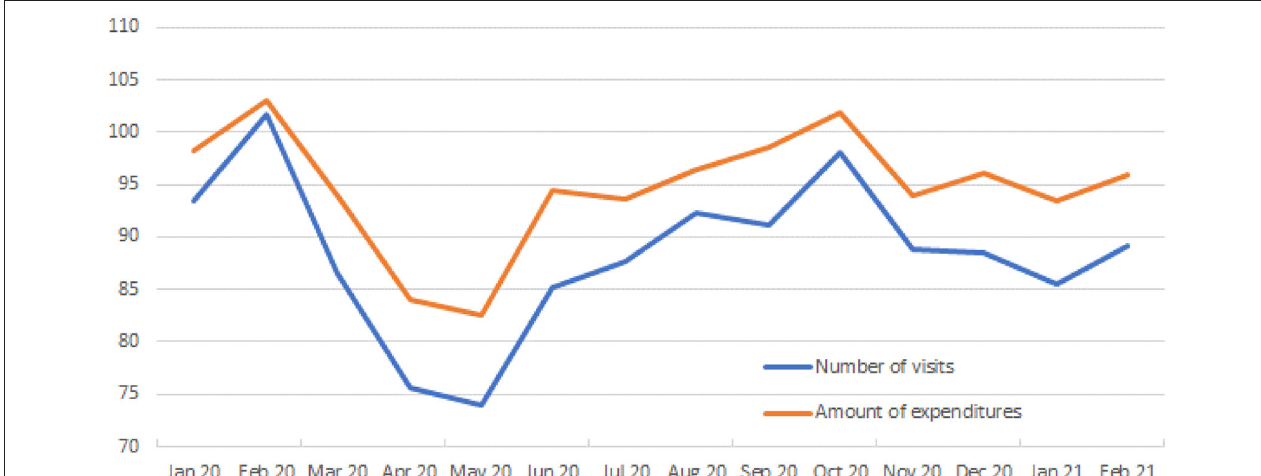
FIGURE 1 | Monthly trends in outpatient visits relative to the same months in 2020–2021. This figure reports the change rate in outpatient visits relative to the same month in the previous year (January 2020–February 2021), not controlling for flu season effects. Data are from the monthly statistics report of the social insurance medical fee payment fund ( Shiharai Kikin ;